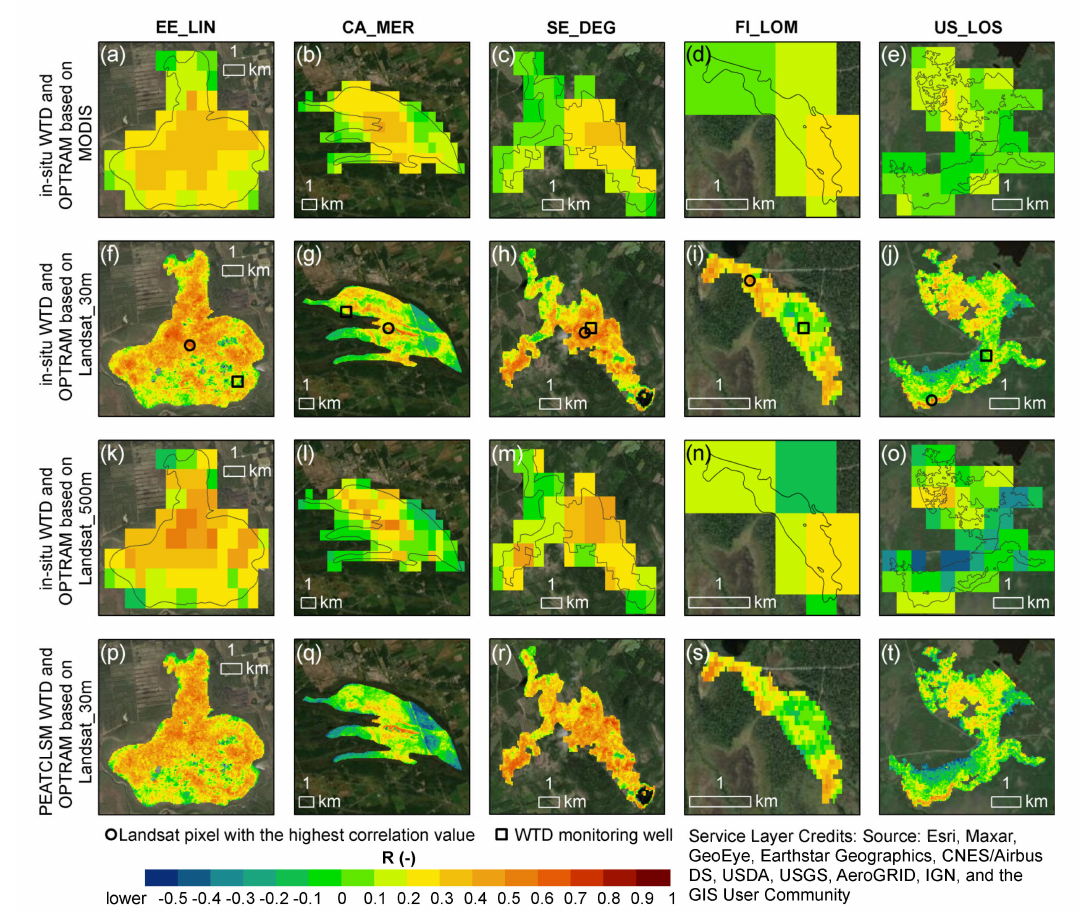
Figure 5. The temporal per-pixel correlation (R) between in situ water table depth (WTD) and OPTRAM based on Landsat_30m ( a–e ), MODIS ( f–j ) and Landsat_500m ( k–o ), and between WTD modeled with PEATCLSM and OPTRAM based on Landsat_30m ( p–t ). Panels f–j show the location of the monitoring wells (black square) and the pixels of Landsat_30m data with the highest temporal correlation with in situ WTD, i.e., the ‘best pixel’ (black circle). The abbreviations of peatlands are given in Table